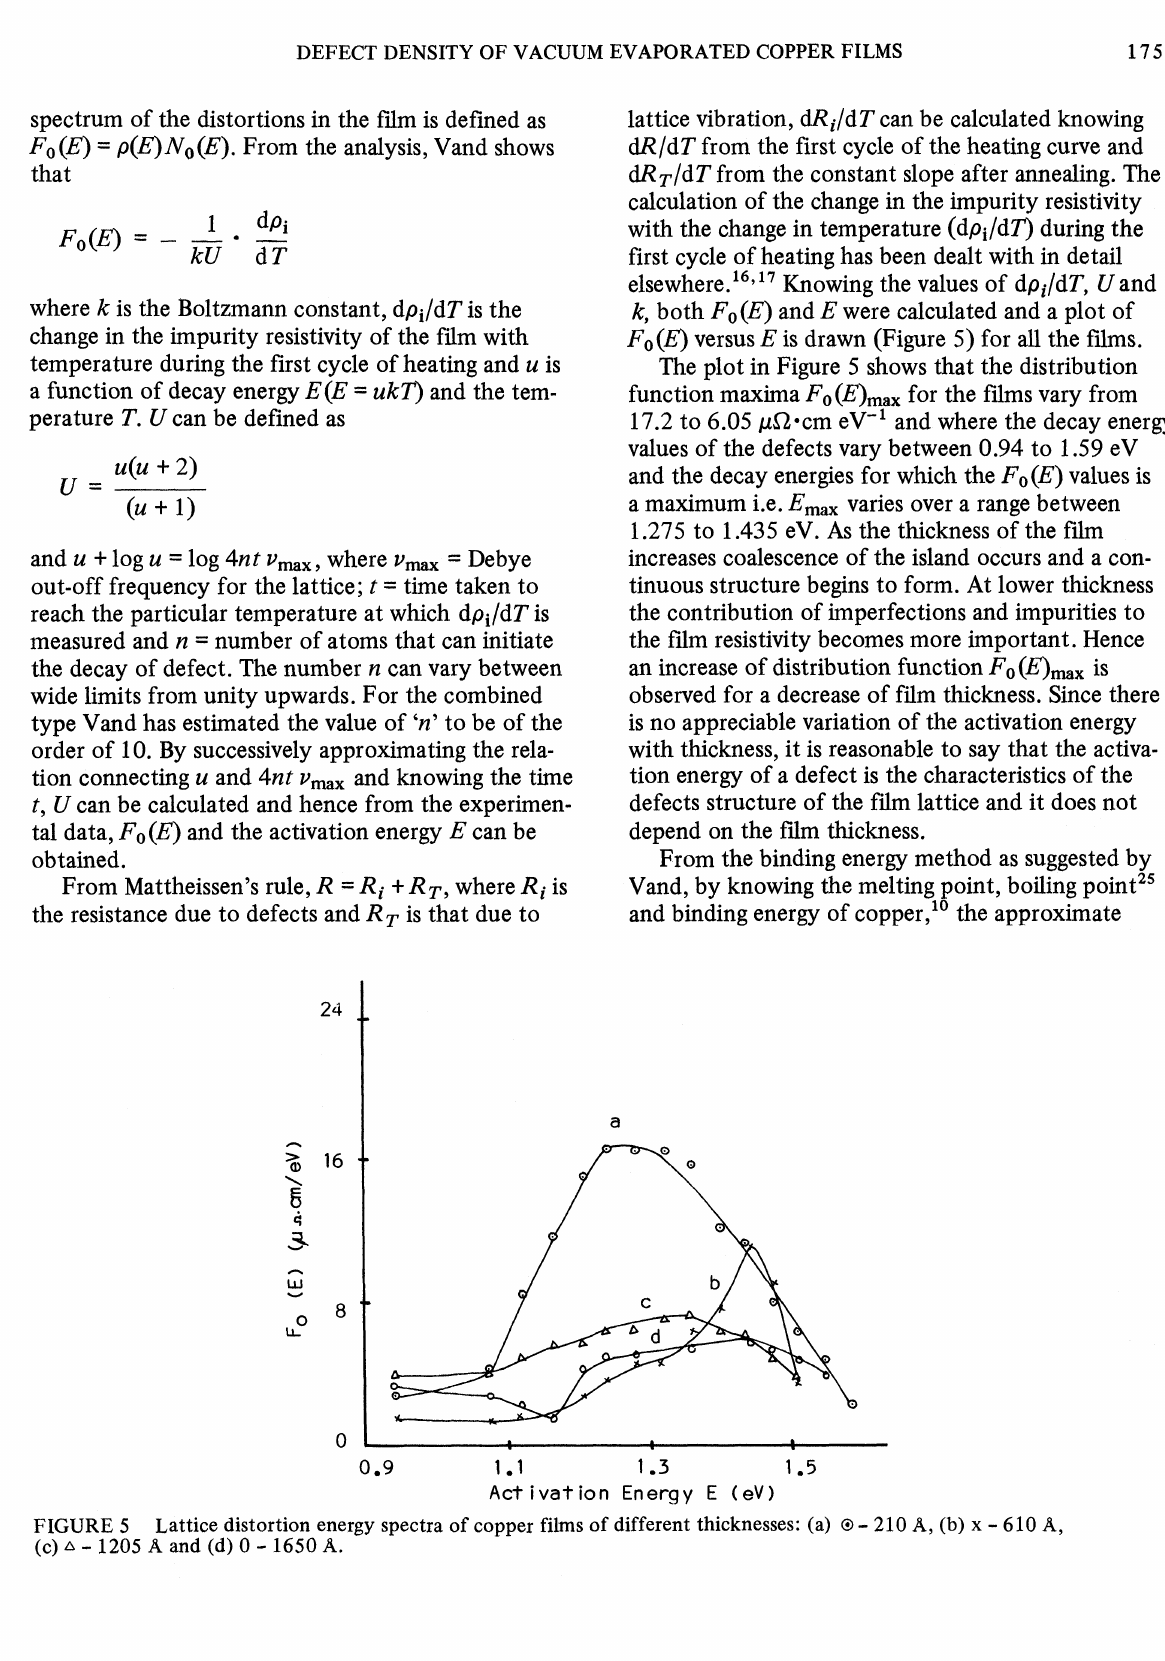
Lattice distortion energy spectra of copper films of different thicknesses: (a) (R)- 210 A, (b) x 610 A, (c) 1205 A and (d) 0 1650